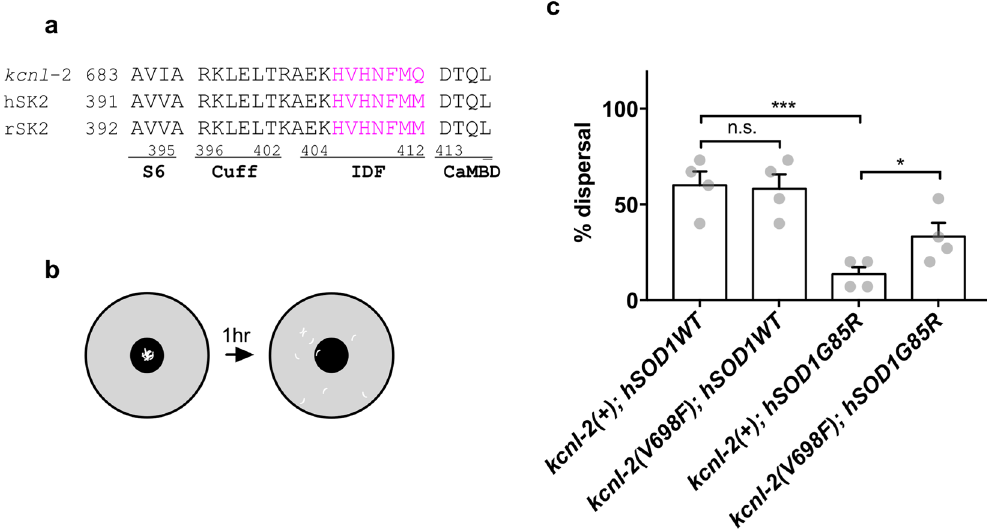
Figure 6. Phenylalanine substitution of the cognate valine in C . elegans kcnl - 2 ameliorates SOD1G85R ALS model locomotion defects. ( a ) Amino acid sequence alignment of mammalian SK2 channels and orthologous C . elegans KCNL-2 at the region connecting the CaMBD and the S6 transmembrane domain. Amino acids are numbered according to KCNL-2 isoform j. Seven amino acid residues from the IDF shown in magenta are the focus of this study. Human and rat SK2 sequences are identical in this region. ( b ) Diagram: to measure locomotion defects, adult animals were scored for dispersal 1 hour after they were placed at the center of a thin bacterial lawn on a 60-mm petri dish (food source). Coordinated animals disperse radially from the center of the bacterial lawn. Uncoordinated animals disperse more slowly. ( c ) Pan-neuronal expression of hSOD1G85R slowed dispersal, compared to hSOD1WT controls (one-tailed t -test, P = 0.0006; n = 60). Phenylalanine substitution of the cognate valine in C . elegans kcnl - 2 increased dispersal in hSOD1G85R animals, compared to hSOD1G85R animals carrying the kcnl - 2 wild type allele (one-tailed t -test, P = 0.0105; n = 60). Each determination is average of four trials. All data are presented in mean ± s.e.m. All animals were tested in sod - 1 ( tm776 ) null